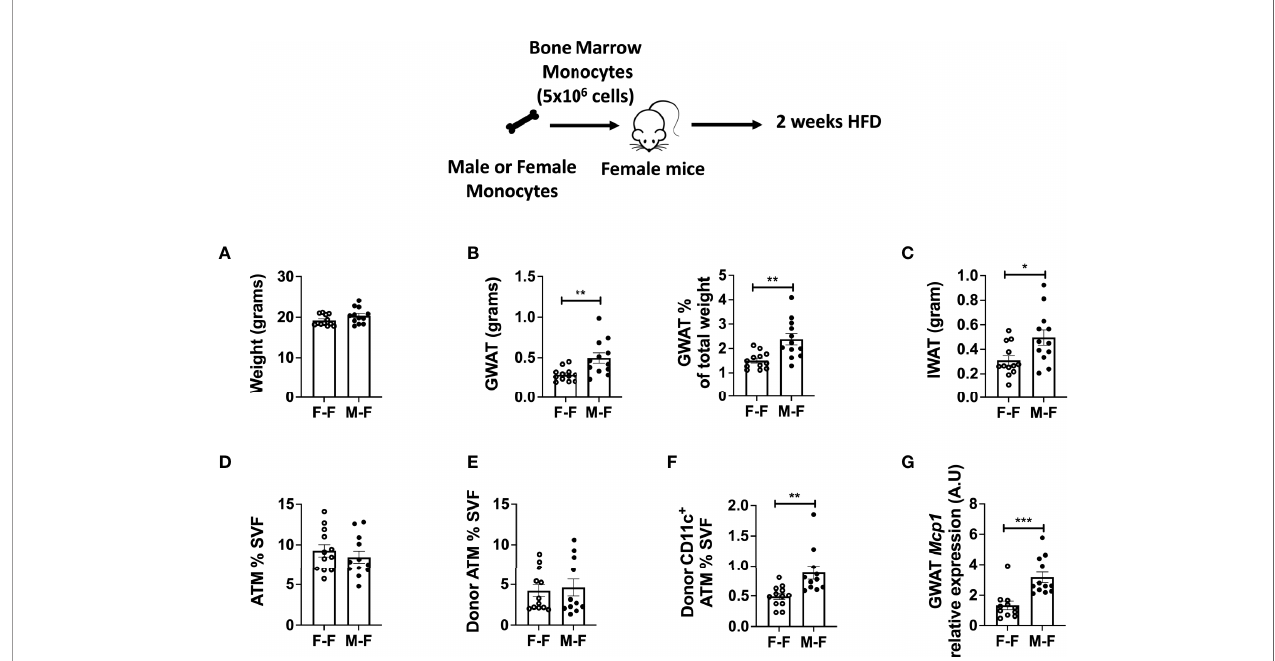
FIGURE 4 | Monocyte transfer demonstrates retained in fl ammatory pro fi le in male myeloid cells. Bone marrow monocytes from either female (F-F) or male (M-F) animals were next transferred into females that were then treated with 2 weeks of HFD. End-point assessments were made in (A) weight, (B) GWAT, % GWAT of total body weight, and (C) IWAT. Flow cytometry assessments of (D) ATM % of SVF, (E) donor ATM %, (F) donor-speci fi c CD11c + ATMs. (G) RT-PCR determined increased Mcp1 in animals given male monocytes. N = 11 – 12 per group. Data were analyzed by two-sample t-test. Data shown as average +/- SEM. *p < 0.05, **p < 0.01 and ***p <